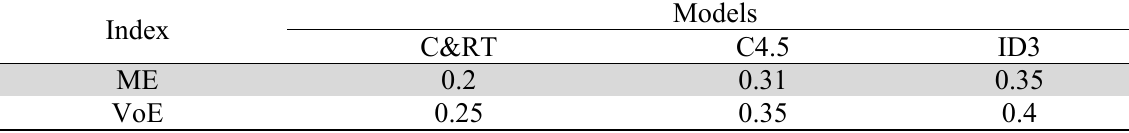
Fig. 3. Validation of decision tree methods with ME and VoE comparison Compared existing of decision tree